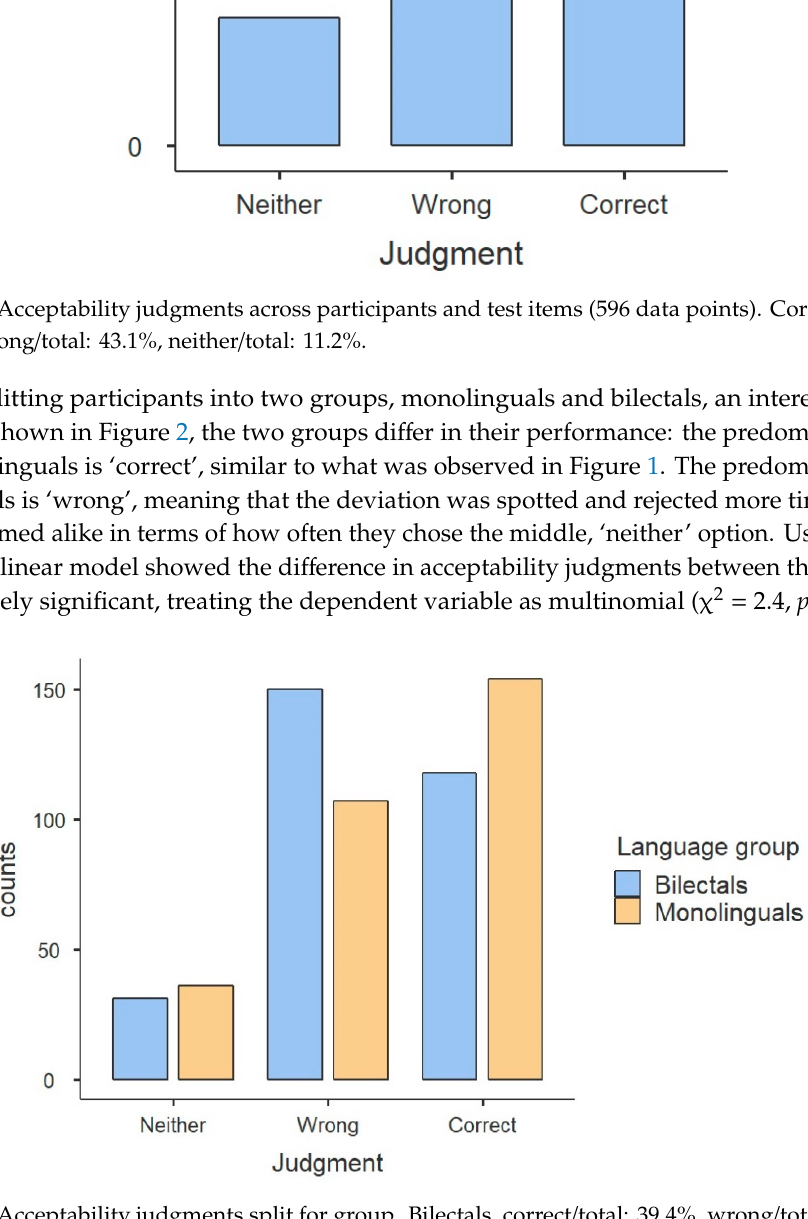
Figure 2. Acceptability judgments split for group. Bilectals, correct/total: 39.4%, wrong/total: 50.1%. neither/total: 10.3%. Monolinguals, correct/total: 51.8%, wrong/total: 36%. neither/total: 12.1%.